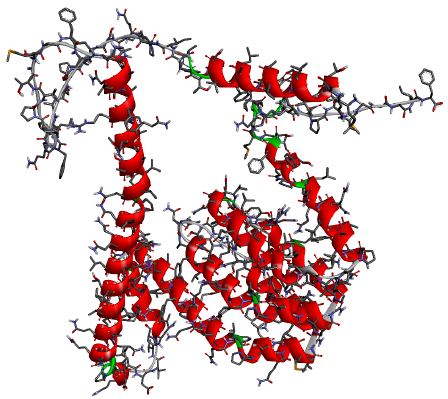
Figure 19. The 3D structure of zein protein downloaded from the European molecular biology laboratory (EMBL-InterPro) with the code Q9SYT3_MAIZE.